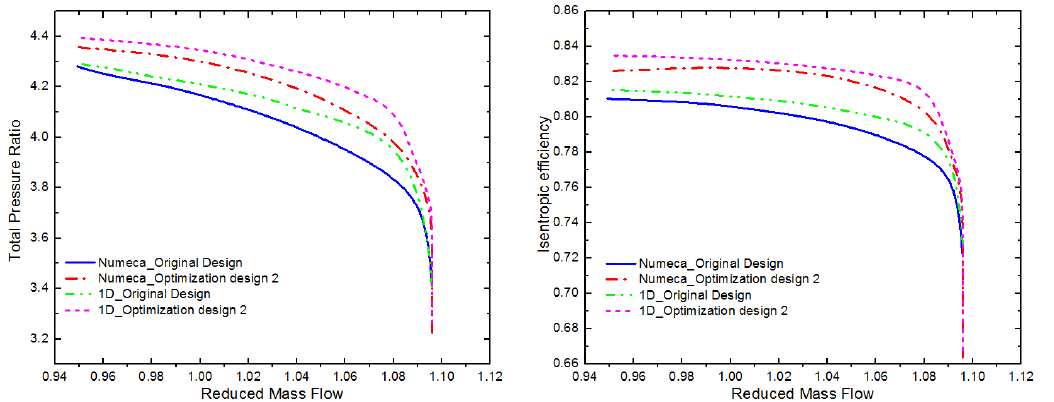
Figure 8. Performance map of original design and optimization design